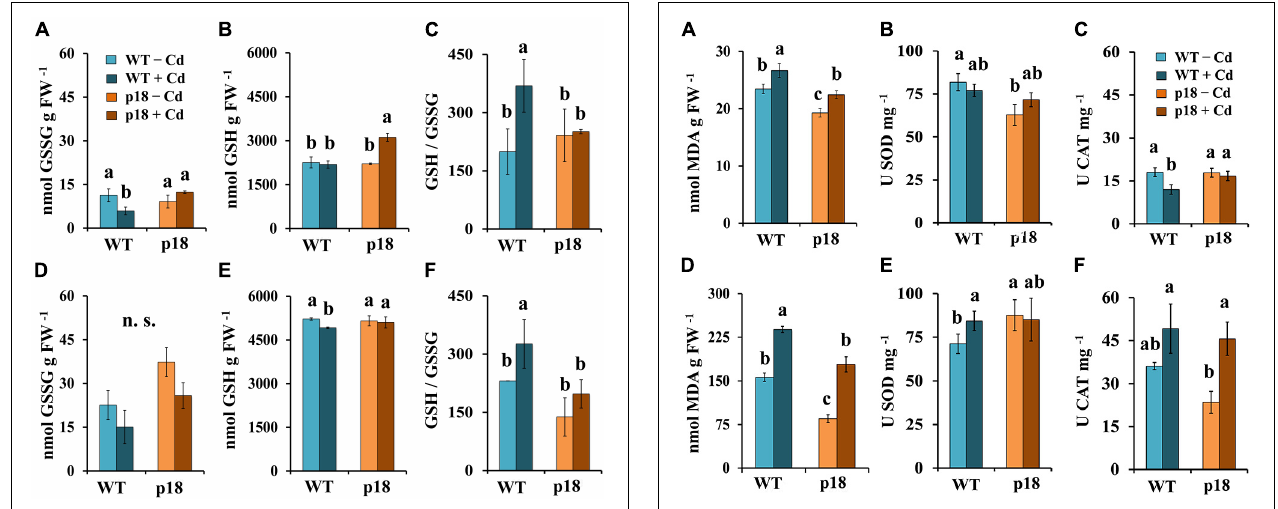
FIGURE 5 | Cadmium effect on the levels of oxidized gluthathione (GSSG), reduced glutathione (GSH) and GSH/GSSG ratio in M. truncatula WT and transgenic p18 roots (A–C) and shoots (D–F) . Plants were grown in pots with 0 or 100 µ M CdCl 2 for 32 days. Bars indicate standard deviation. Different letters denote significant differences, Tukey HSD, p < 0.05, n = 4; n.s. not significant.